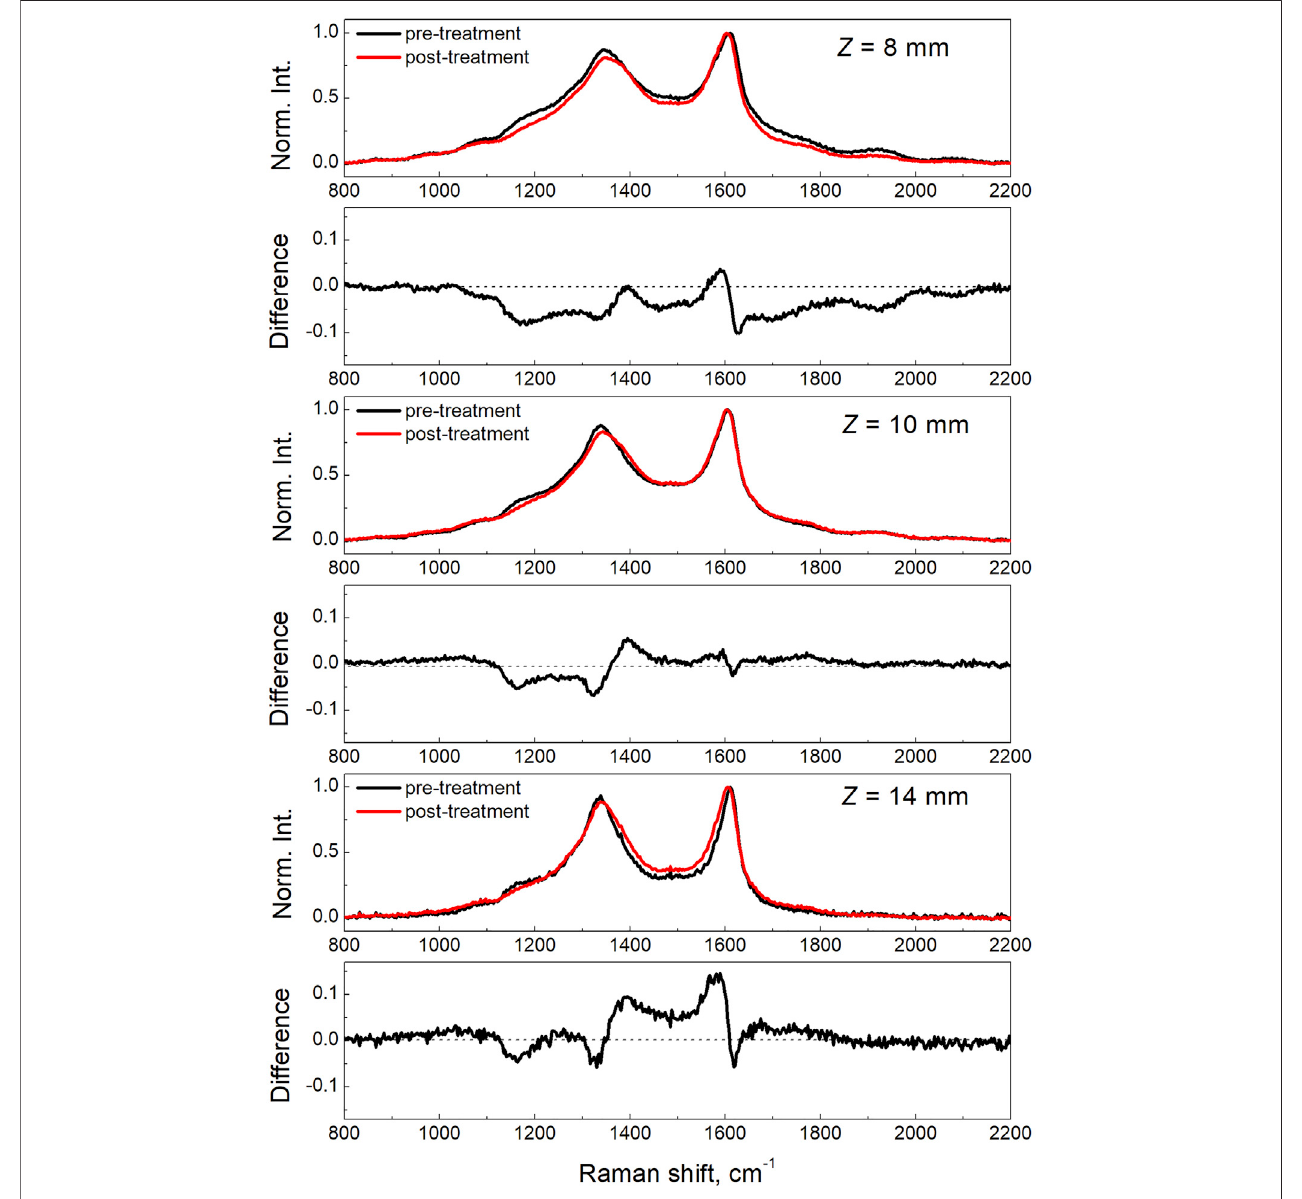
FIGURE 6 | Raman spectra of the three soot samples acquired at ambient temperature before and after the thermal/oxidation treatment performed up to a maximum temperature of 500 ° C.